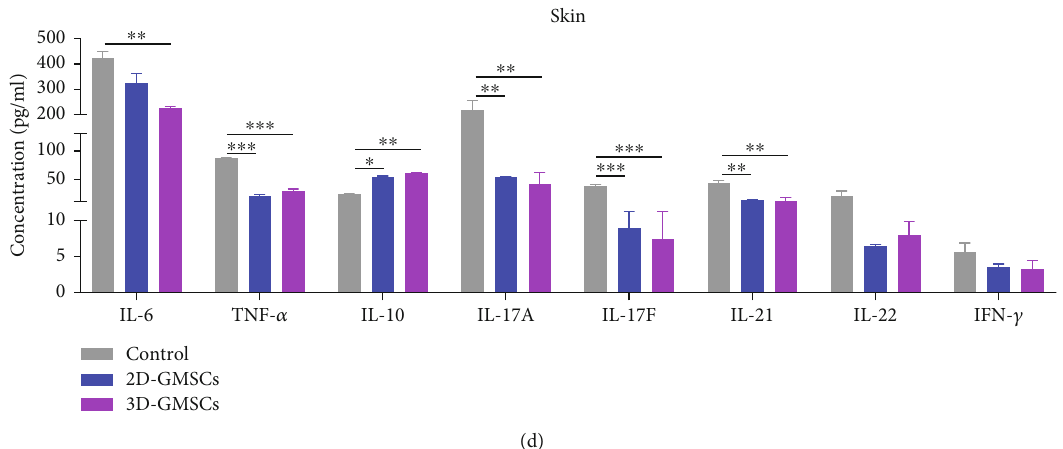
Figure 4: 2D-GMSCs and 3D-GMSCs signi fi cantly inhibited the skin in fl ammatory response in IMQ-induced mice. (a) Representative HE staining of mouse back skin. (b) Immunohistochemical studies were performed using antibodies for mouse TNF- α , IL-6, IFN- γ , and IL-17A. (c) The relative expression levels of TNF- α , IL-6, IFN- γ , and IL-17A were analyzed by pathological score (PS). ∗ p < 0 : 05 ; ∗∗ p < 0 : 01 ; ∗∗∗ p < 0 : 001 . (d) The protein expression level of in fl ammatory cytokines in the skin tissue lysate evaluated via multiplex LEGENDplex analysis. ∗ p < 0 : 05 ; ∗∗ p < 0 : 01 ; ∗∗∗ p < 0 : 001